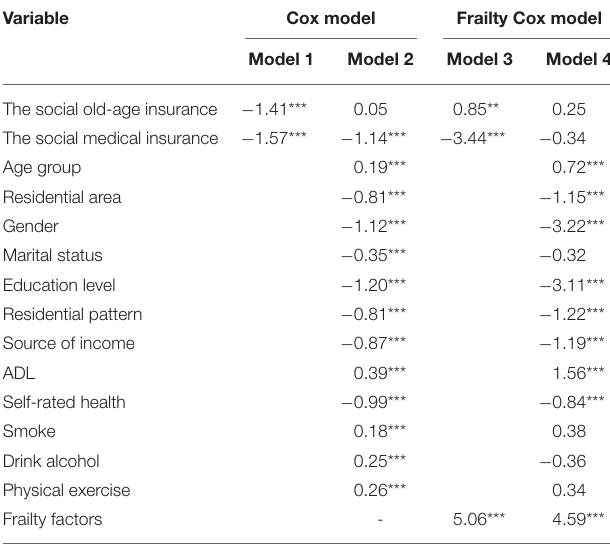
TABLE 2 | The regression results of the Cox model and the frailty Cox model under the overall